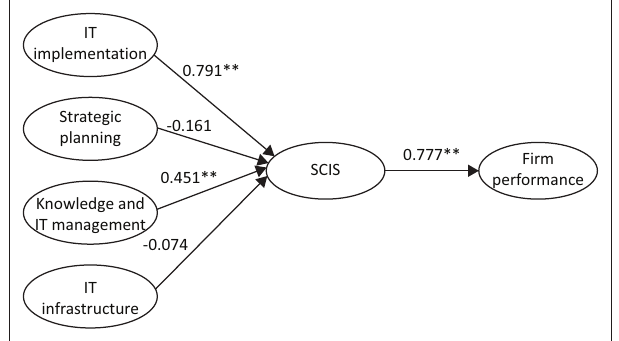
FIGURE 3 : Path diagram.